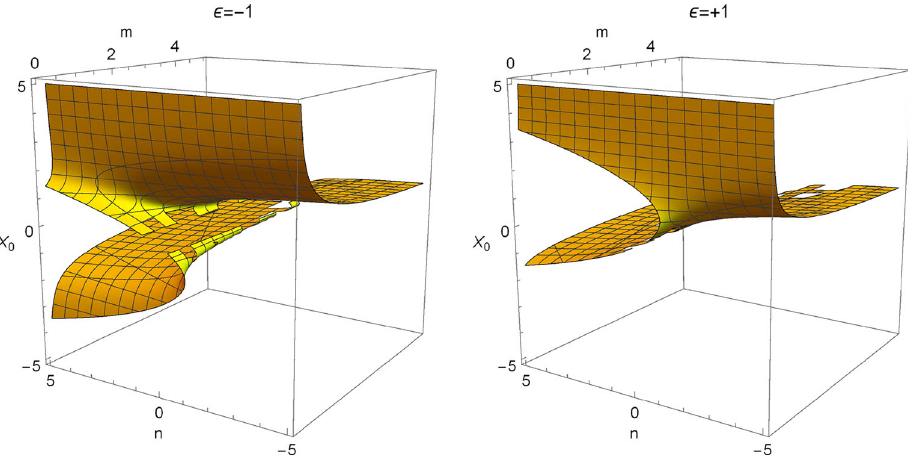
Fig. 13 The variation X 0 versus typical values of the m and n parameters in (66) for the cosmological constant-like background